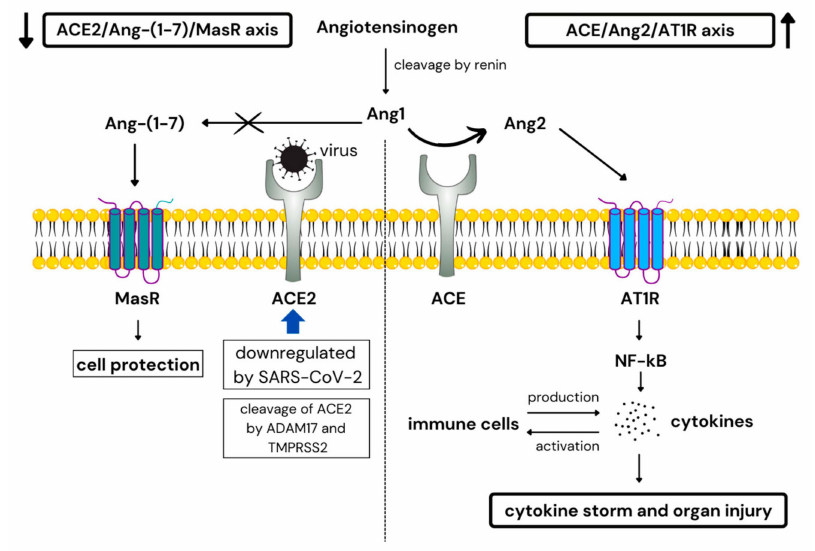
Figure 2. ACE/Ang2/AT1R and ACE2/Ang-(1-7)/MasR axis during COVID-19. ACE—angiotensin- converting enzyme, ACE2—angiotensin-converting enzyme 2, ADAM17—A disintegrin and met- alloproteinase 17, Ang—angiotensin, AT1R—angiotensin II receptor type 1, MasR—Mas receptor, NF- κ B—nuclear factor kappa